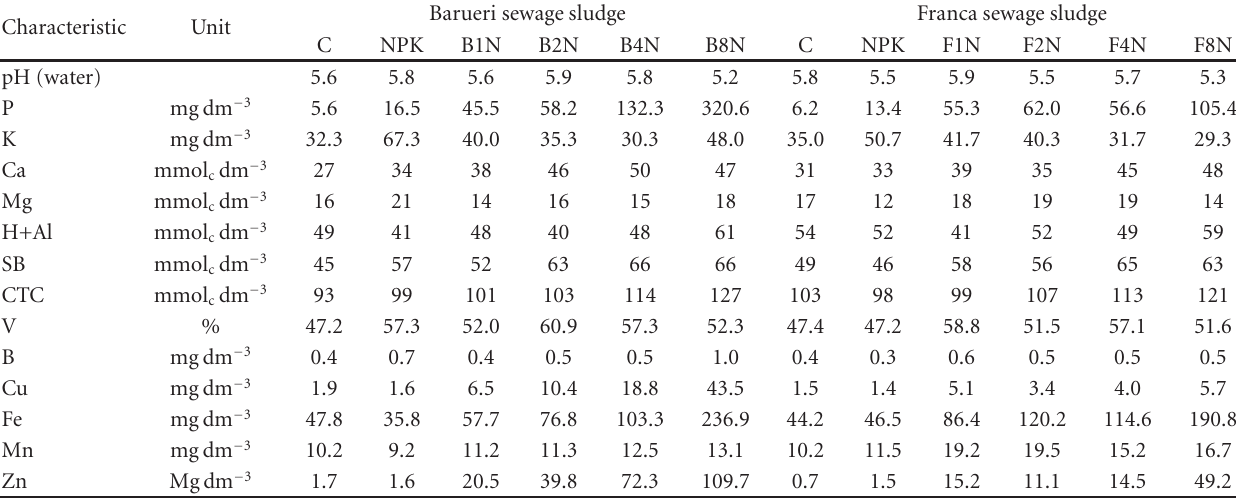
Table 3: Chemical characteristics of the soil after five application of Barueri (B) and Franca (F) sewage sludge.